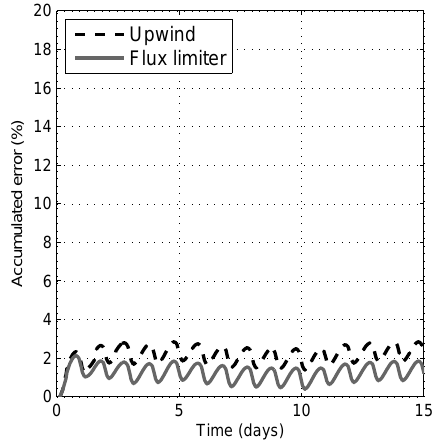
Fig.8: ComparisonsbetweenaccumulatedmassbalanceerrorsconsideringapulseinputoftracerconcentrationintoRiverGua´ıbaduring10hoursforthe fluxlimiterandupwindschemes. Fig. 8. Comparisons between accumulated mass balance errors con- sidering a pulse input of tracer concentration into the Guaíba River during 10h for the flux-limiter and upwind schemes.